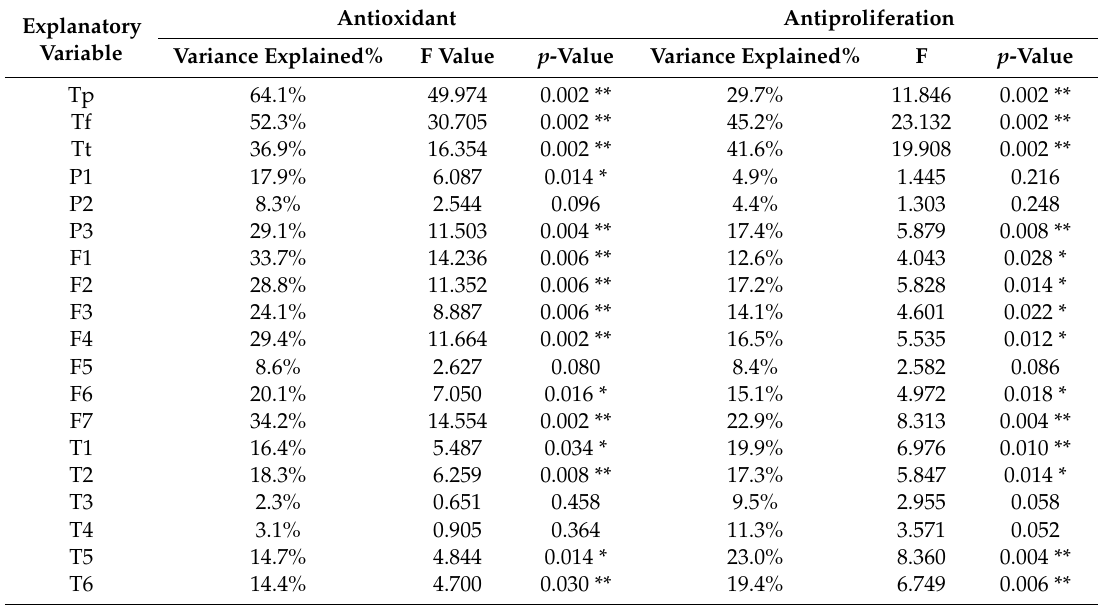
Table 6. The explanation and significance of variables in RDA